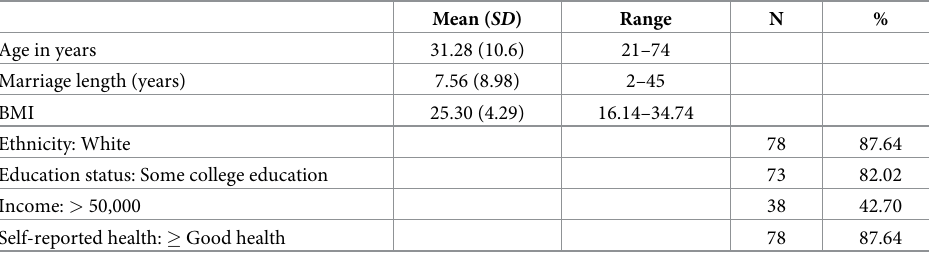
Table 1. Demographic